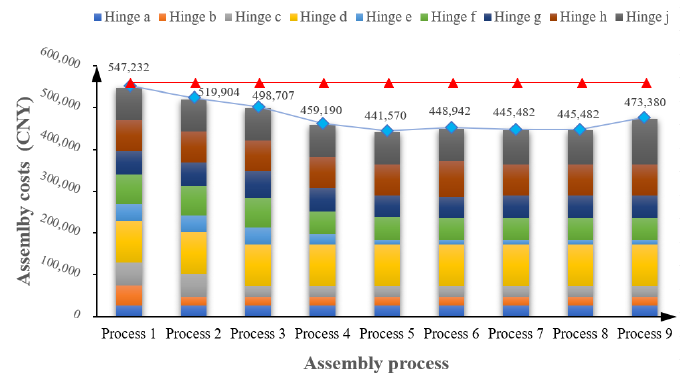
Figure 19. Assembly costs of different methods.